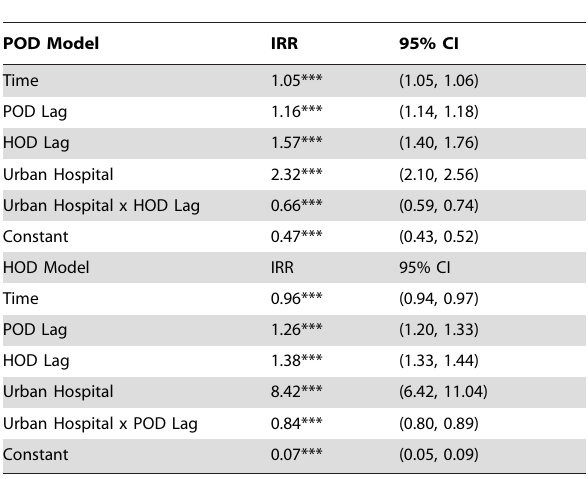
Table 2. Negative Binomial Lag Models for PODs and